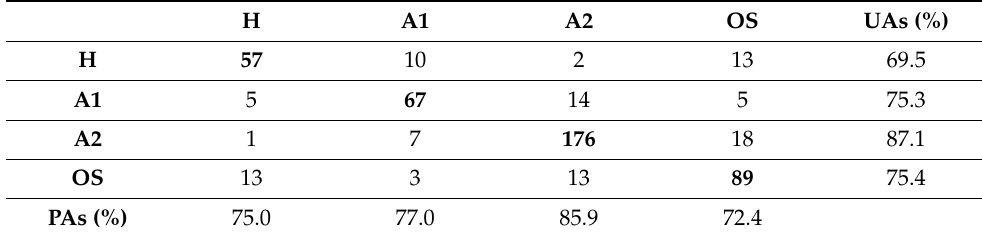
Table 6. Confusion matrix for the map of the 30 September 2020, considering both species and bark beetle attack classifications. Numbers in bold are the diagonal of the matrix.